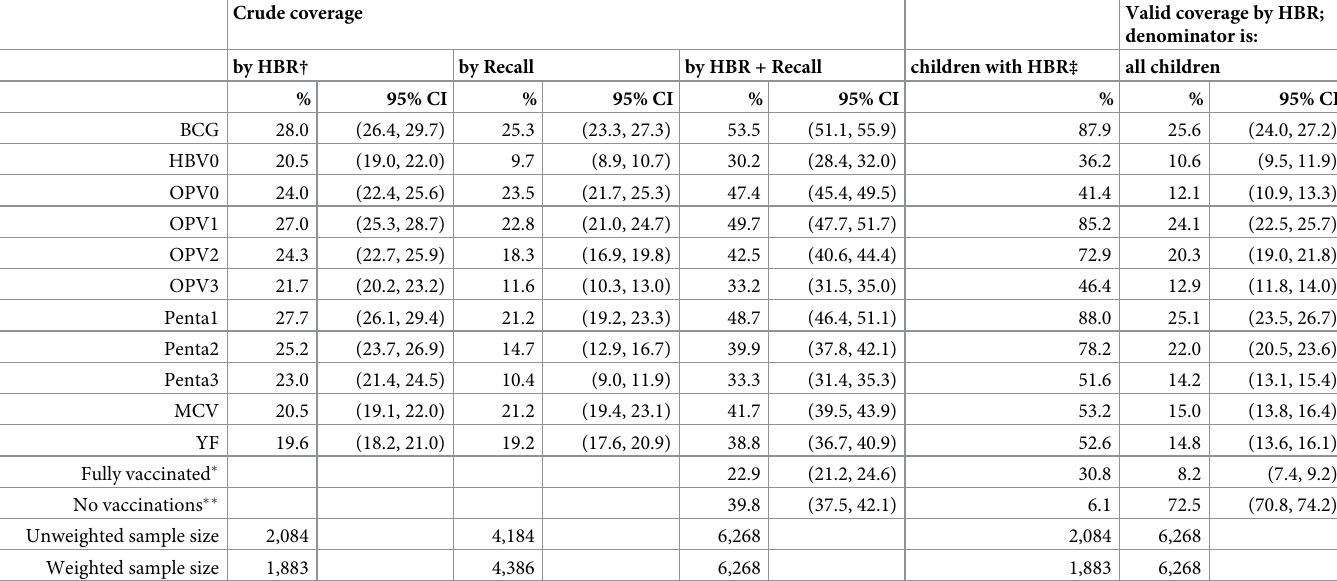
Table 1. Weighted percentage crude (ignoring age at vaccination or interval between doses) and valid (respecting the schedule) vaccination coverage for the basic EPI vaccines, children aged 12–23 months, MICS/NICS 2016–17. Crude coverage Valid coverage by HBR;